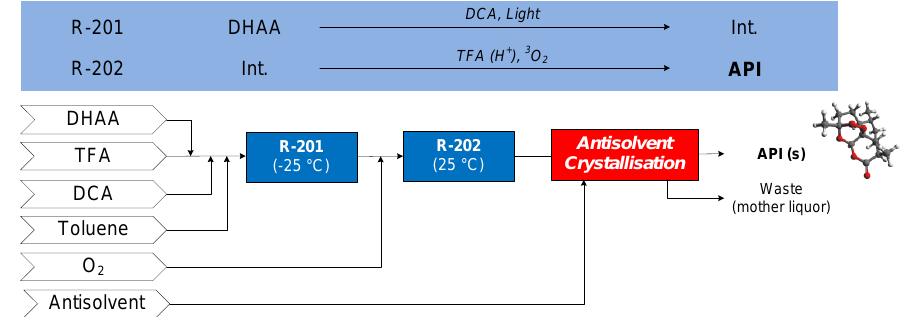
Figure 12. CPM flowsheet for artemisinin: flow synthesis [64] + continuous LLE [63]. Reproduced